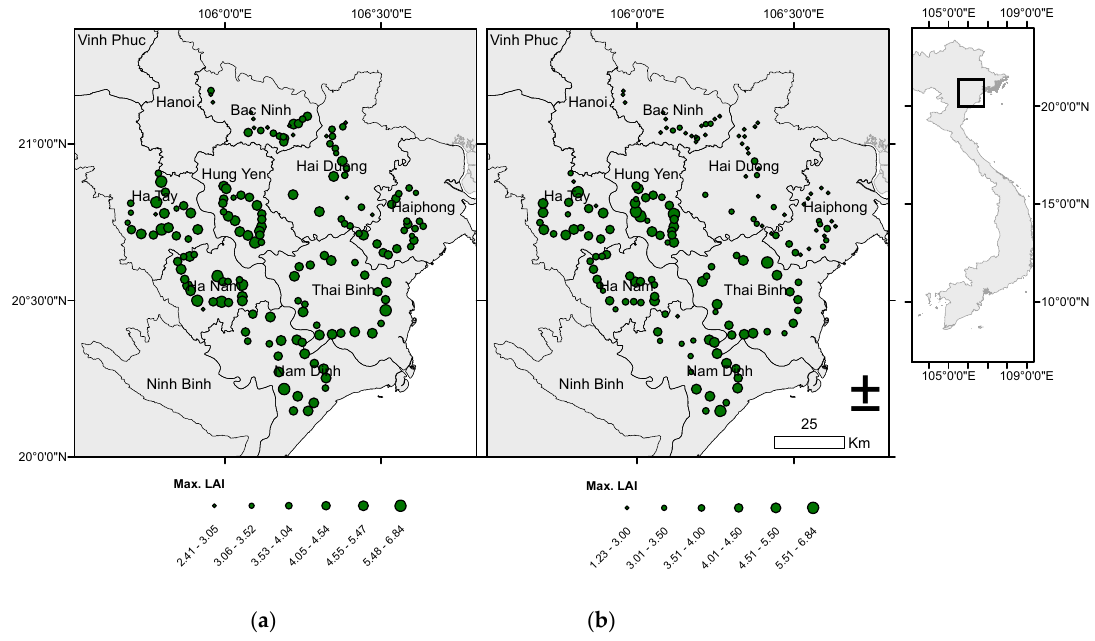
Figure 1. Maps of the study site in the Red River Delta, Vietnam. Graduated symbols indicate the magnitude of maximum LAI measured in situ during the 2016: spring ( a ); and summer ( b ) seasons.